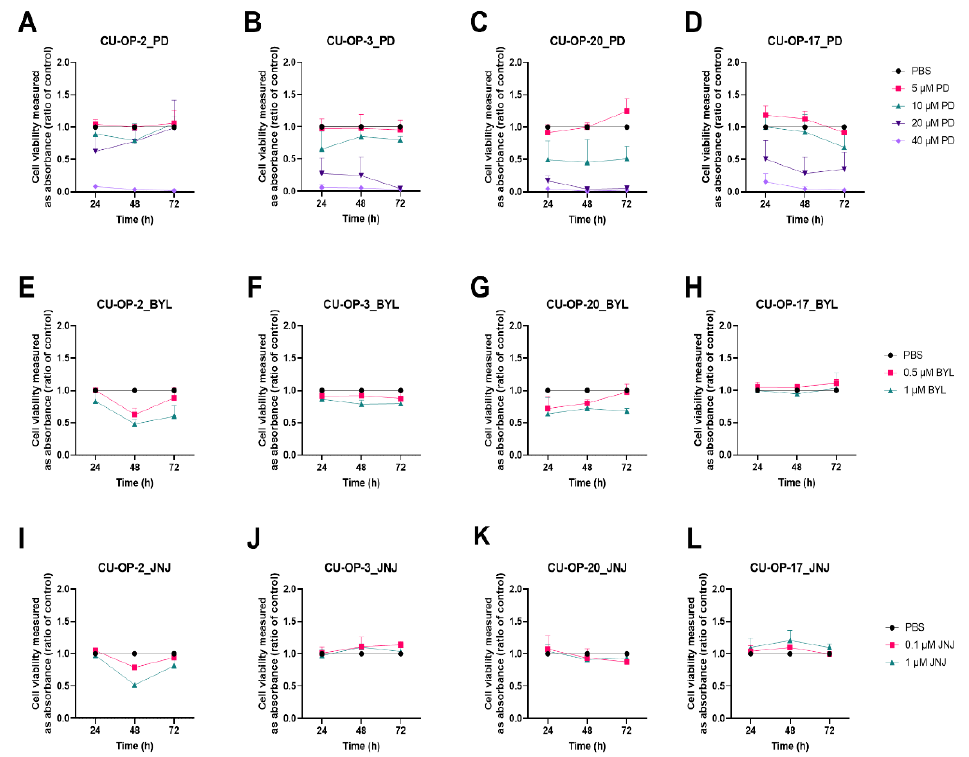
Figure 1. WST-1 viability assay on HPV + cell lines CU-OP-2, CU-OP-3 and CU-OP-20 and HPV − cell line CU-OP-17. Cell viability analysis measured as absorbance after 24, 48 and 72 h of single treatment with PD-0332991 ( A – D ), BYL719 ( E – H ), JNJ-42756493 ( I – L ). PD denotes PD-0332991; BYL denotes BYL719; and JNJ denotes JNJ-42756493.